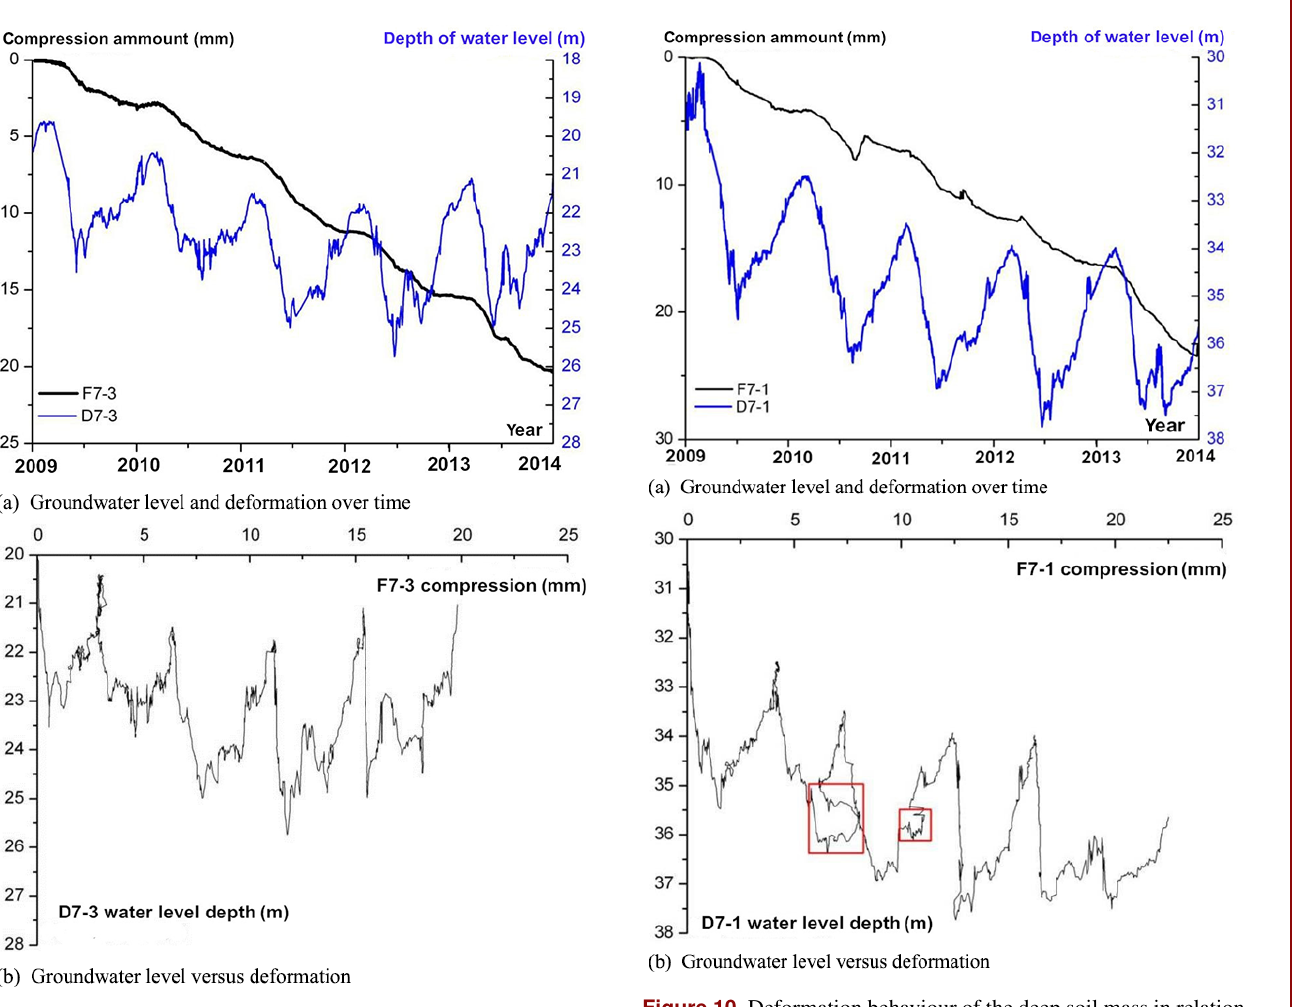
Figure 9. Deformation behaviour of the middle soil mass in relation to its corresponding groundwater level at layered mark F7-3.